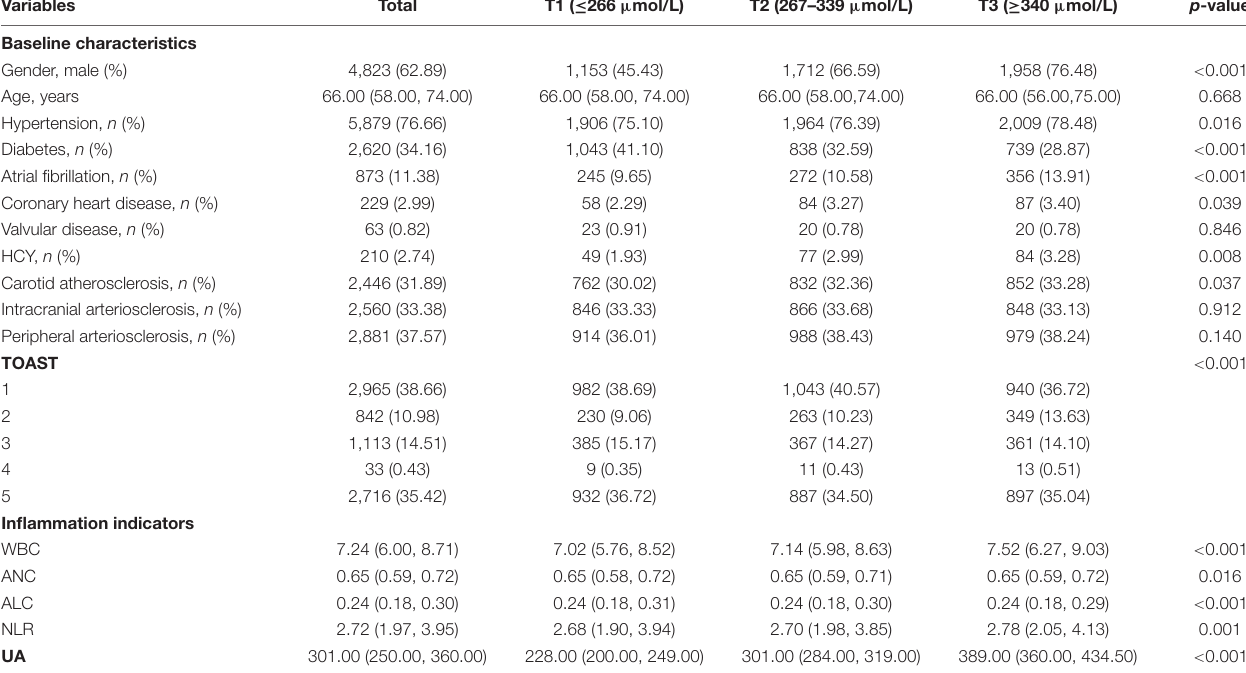
TABLE 1 | Baseline characteristics of participants according to tertiles of